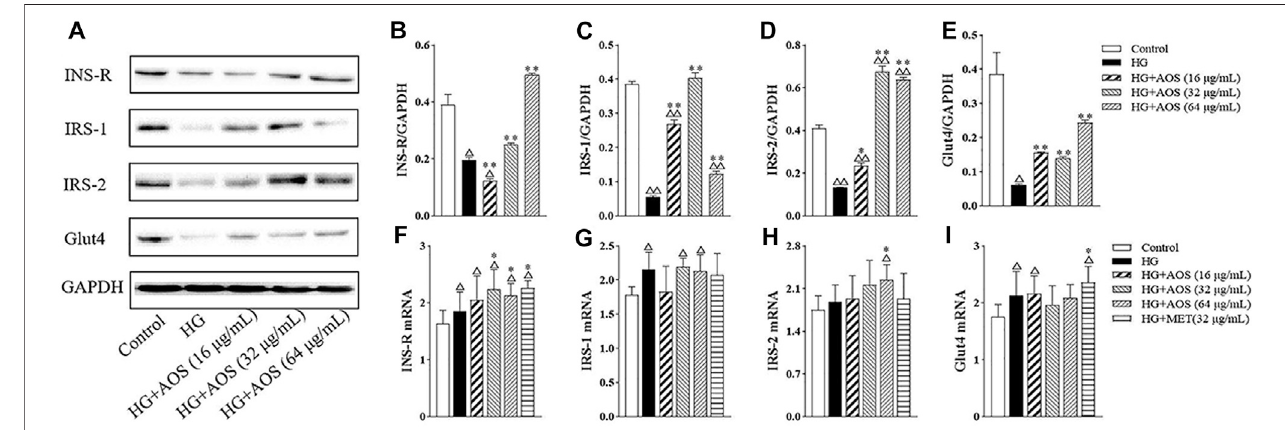
FIGURE7| TheeffectsofAOStreatmentattheinsulinsignalingpathwayofMIN6cells. (A) WesternblottingofINS-R,IRS-1,IRS-2,andGlut4proteinexpressionin the cells. (B,C, D, E) Fold changebythe positivecontrol(HG +MET). (F,G, H, I) Relative mRNAexpression against GAPDH inMIN6 cells. Alldata areexpressed asthe